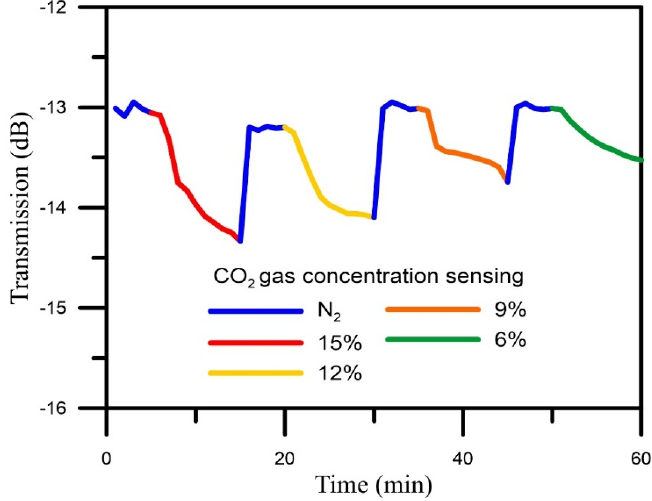
Figure 6. The curve of CO 2 gas sensing with four different